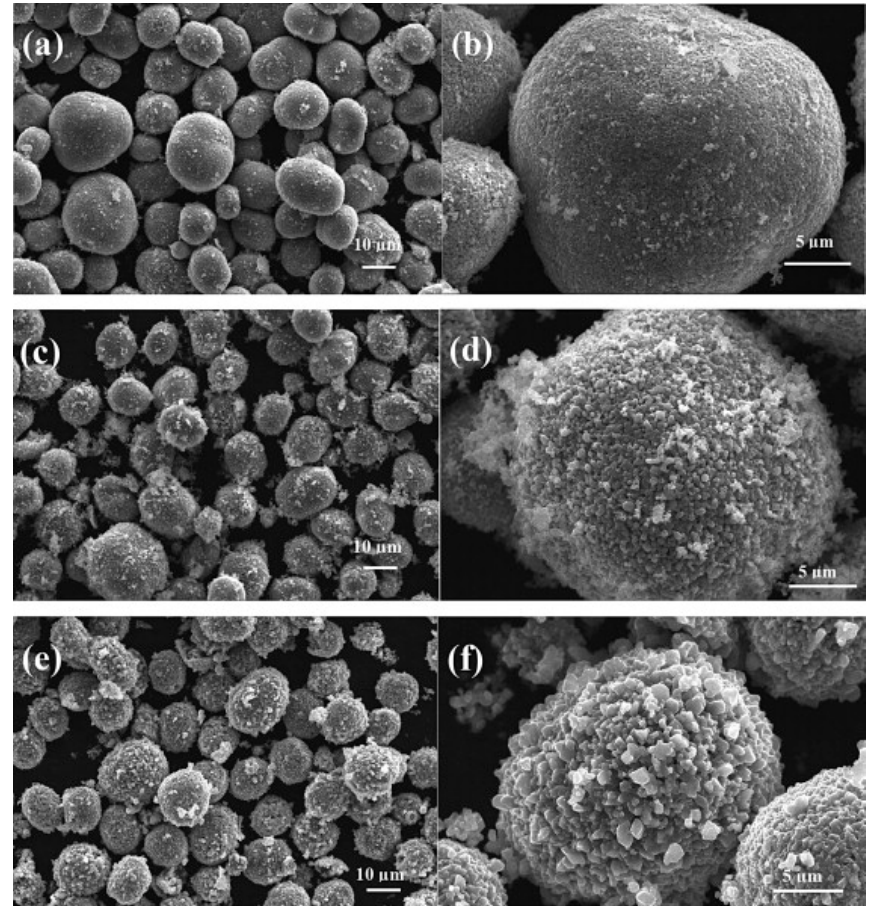
Figure 4. SEM images of spherical Li 1+x Ni 0.5 Mn 0.5 O 2+ δ made from spherical Ni 0.5 Mn 0.5 CO 3 carbon- ate precursor by Coprecipitation assisted RPR method ( a , b ) x = 0, ( c , d ) x = 0.1 and ( e , f ) x = 0.2 Reprint with permission [55] © 2008 Elsevier Inc. All rights